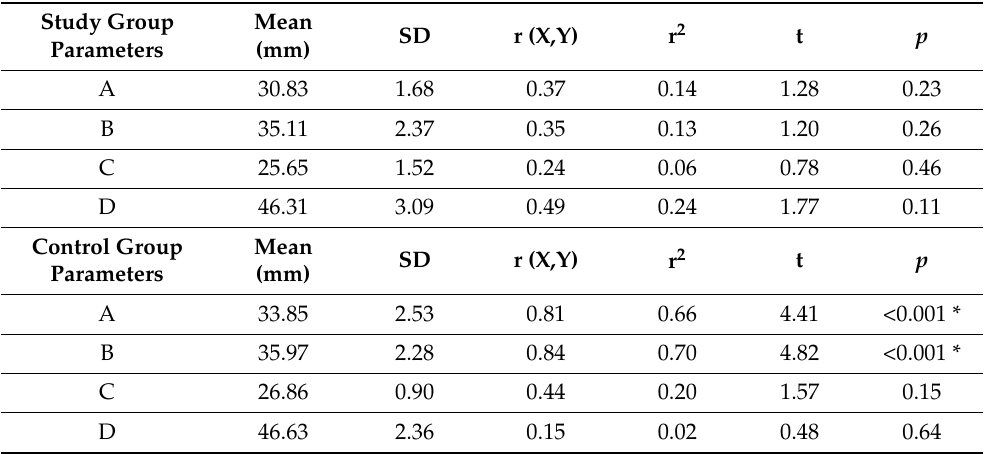
Table 2. Correlations between age and maxilla and mandible